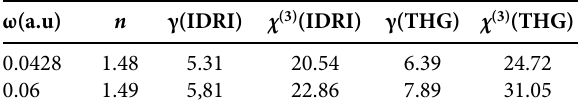
Table 4: CAD embedded molecules linear refractive index and the IDRI and THG results for γ (10 –36 esu ) and the χ (3) (10 –22 m 2 /V 2